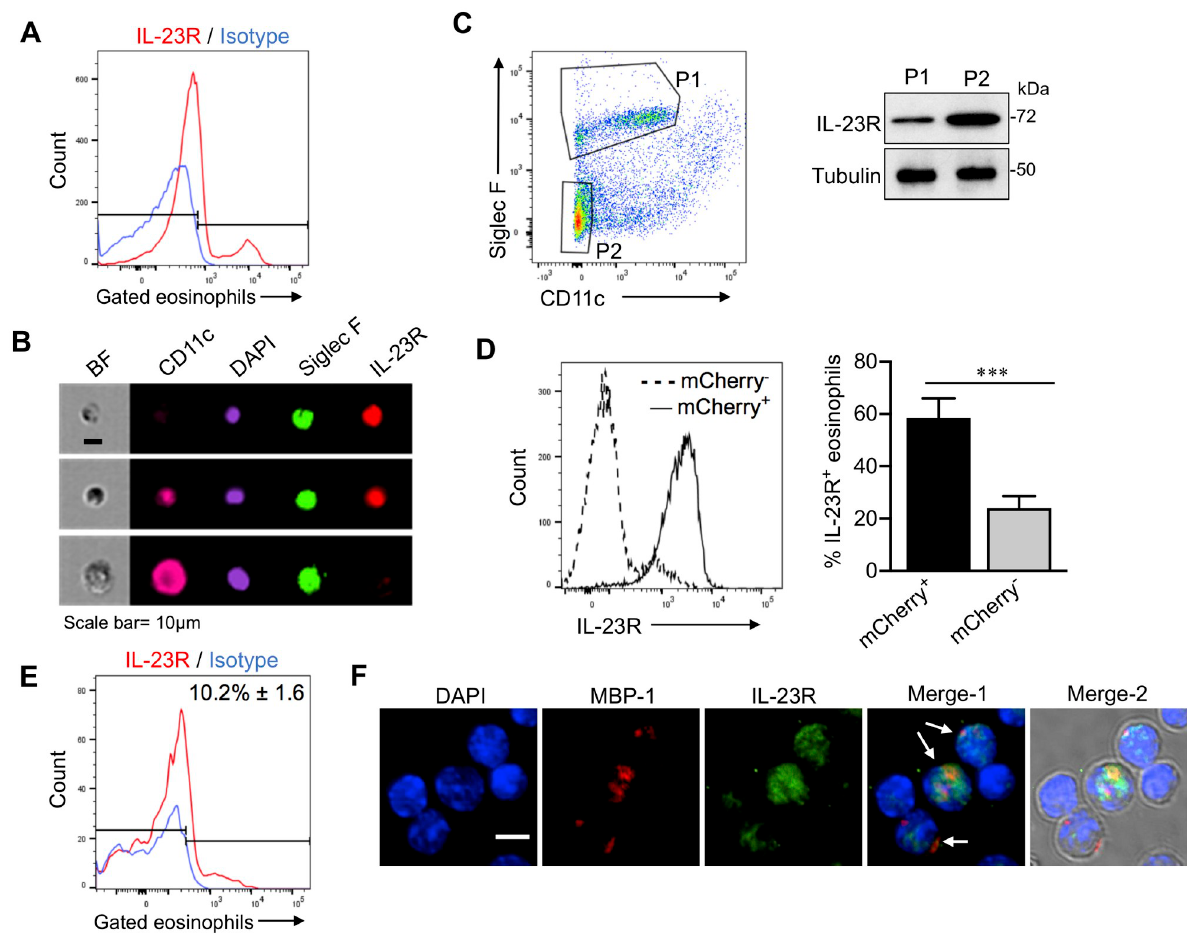
Fig 4. Eosinophil IL-23R expression from mice with acute and allergic pulmonary aspergillosis. (A) Flow cytometry (allergy model) . Allergic aspergillosis was induced in C57BL/6 mice as shown in Fig 1A. Single cells were prepared from harvested lungs and stained for CD45, CD11c, Siglec F and IL-23R. Live cells in the eosinophil gate were then analyzed by flow cytometry. A representative histogram is shown comparing IL-23R expression on eosinophils with an isotype control. The means ± SE (n = 5 mice) of IL-23R-positive eosinophils are shown next to the histogram. (B) Imaging flow cytometry (allergy model) . As in Fig 4A except cells were analyzed by imagining flow cytometry. Shown are representative output images (original magnification 20X). The top two panels demonstrate representative IL-23R + eosinophils, one of which is CD11c - and the other CD11c int . The lower panel shows a presumed alveolar macrophage (AM φ ), distinguished from an eosinophil based on its larger size, high levels of CD11c expression and nuclear morphology. BF; Bright field. Cells shown are representative of > 100 analyzed cells. Scale bar = 10 μ m. (C) Immunoblotting (allergy model) . Allergic aspergillosis was induced in C57BL/6 mice as in Fig 1A, following which lungs were harvested and single cell preparations were made. The left figure shows the sorting gates of the two different cell populations used for immunoblotting of IL-23R. P1: eosinophils, P2: SigF - CD11c - cells. Whole cell extracts were made, resolved by SDS-Page and immunoblotted with primary antibodies for IL-23R and α -tubulin. The immunoblot is representative of 2 independent experiments. Tubulin was used as a loading control. (D) Flow cytometry (allergy model , mCherry reporter mice) . Allergic aspergillosis was induced in ROR γ t-mCherry reporter mice as described in Fig 1A. After harvesting lungs, single cell lung preparations were made. By flow cytometry, mCherry negative (mCherry - ) and mCherry positive (mCherry + ) lung eosinophils were analyzed for the presence of IL-23R. Left panel: Representative histograms of IL-23R expression in the mCherry - and mCherry + eosinophils. Right panel: Bar graphs showing the mean ± SEM percent IL-23R + eosinophils in mCherry + and mCherry - eosinophils from two independent experiments, each of which had 4–5 mice (p < 0.001 comparing the two groups). (E) Flow cytometry (acute infection model) . C57/BL6 mice were infected with 5x10 7 Af293 conidia. Mice were euthanized 48 hours post-infection, single cell suspensions were made from harvested lungs, and analyzed for IL-23R expression as in Fig 4A. Histograms show the shift in IL-23R signal intensity in gated eosinophils. A representative histogram is shown comparing IL-23R expression on eosinophils with an isotype control. The means ± SE (n = 5–6 mice) of IL-23R-positive eosinophils are shown next to the histogram. (F) Confocal microscopy (acute infection model) . As in Fig 4D except cells were analyzed by confocal microscopy. Merge-1: DAPI + MBP (red) + IL- 23R (green). Arrows point to eosinophils identified based on MBP staining. Merge-2: DAPI (blue) + MBP (red) + IL-23R (green) + brightfield. Scale bar = 10 μ